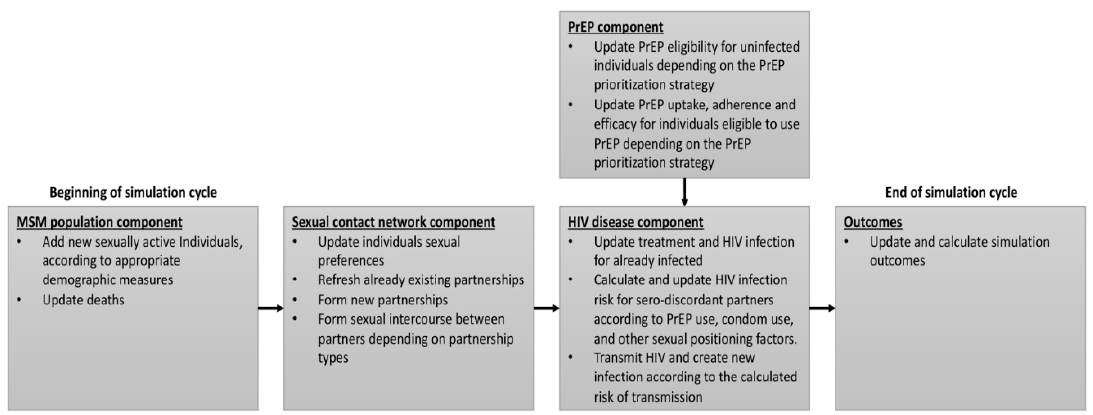
Figure 1. Summary of updates in model components during each simulation cycle. Note: model cycle was defined as a day. Abbreviations: HIV = human immunodeficiency virus; MSM = men who have sex with men; PrEP = pre-exposure prophylaxis; AIDS = acquired immune deficiency syndrome.